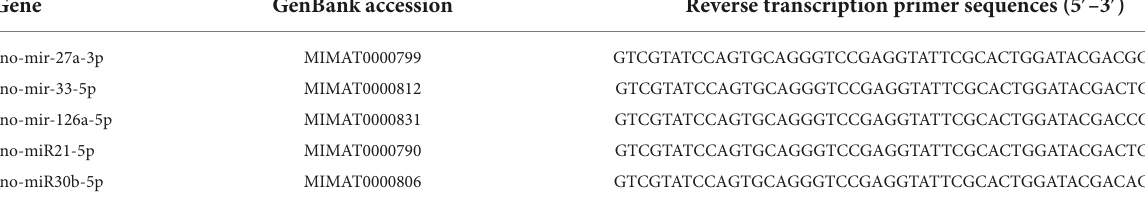
TABLE 2 Reverse transcription primer sequences of miRNAs. Gene